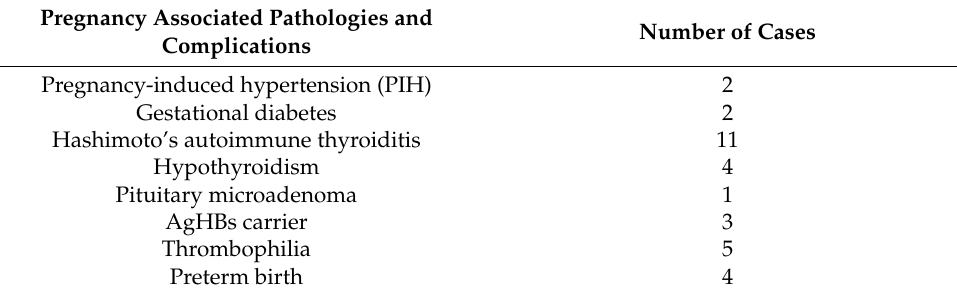
Table 3. Associated pathologies during